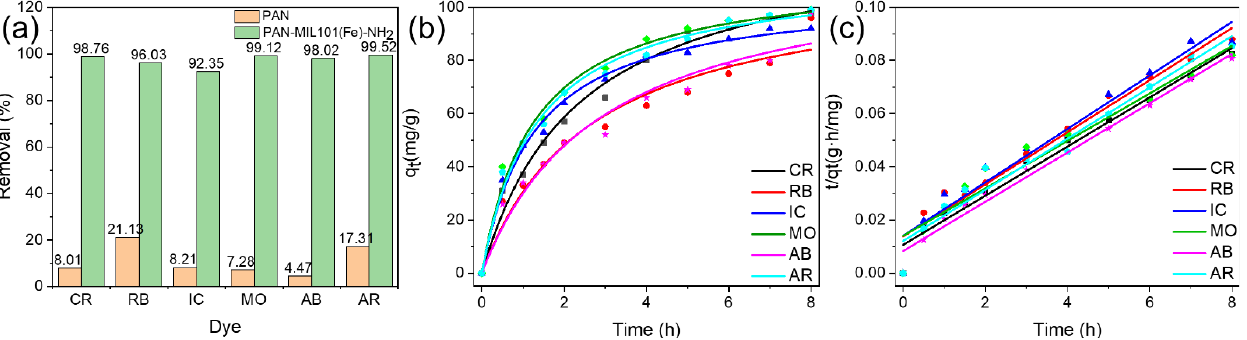
Figure 6. ( a ) Removal efficiency of dyes by the PAN and PAN-MIL101(Fe)-NH 2 NFM. ( b ) Adsorption kinetics and ( c ) pseudo-second-order kinetics of the PAN-MIL101(Fe)-NH 2 for Congo red, rhodamine B, indigo carmine, methyl orange, acid blue 93, and acid red 27.